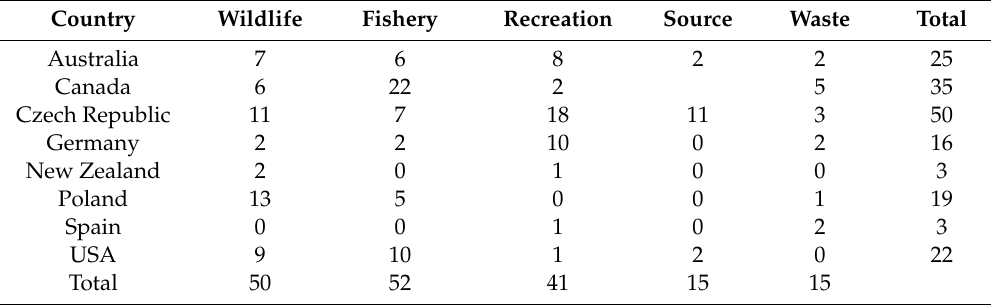
Table 1. Pit lakes with defined pit lake end uses ( n > 1). Country Wildlife Fishery Recreation Source Waste